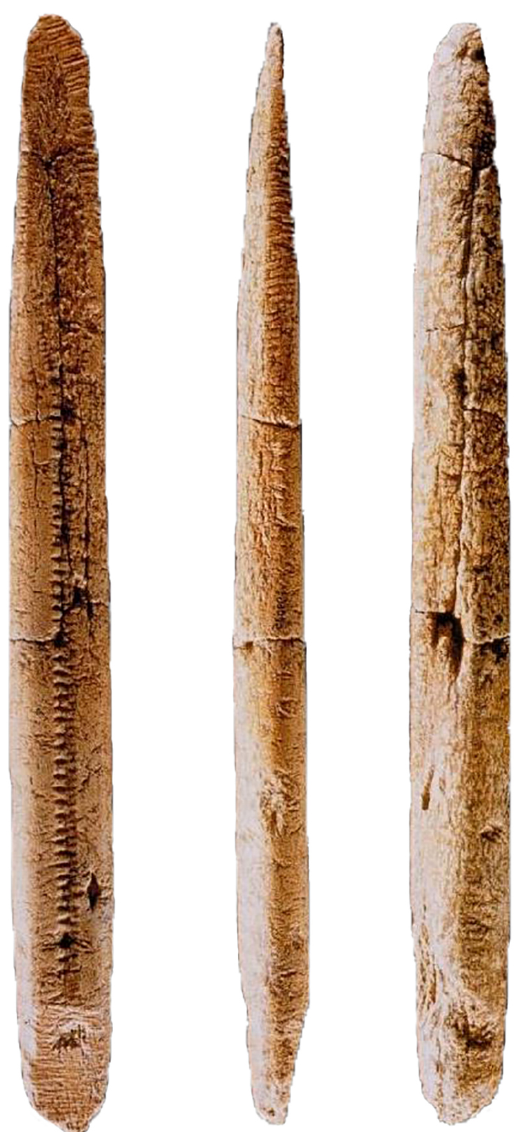
Figure 1. One of the Clovis osseous rods from the East Wennatchee cache that might be a foreshaft which Clovis fluted points were hafted to (after Gramly 1993). Metrics of the rod: length: 26.3 cm; width: 2.4 cm; thickness: 1.8 cm; weight: 75.1